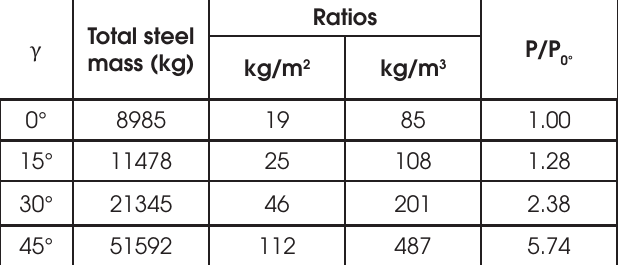
Total steel mass and ratios for girder